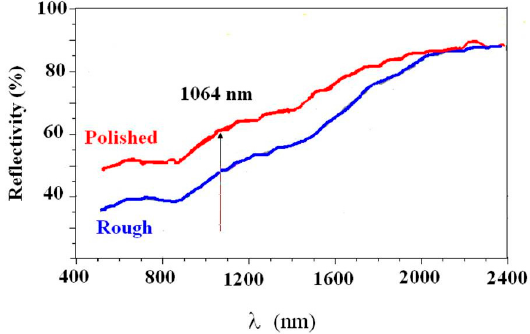
Figure 4. Total reflectivity vs. wavelength λ . The two curves refer to W with polished and rough surfaces.